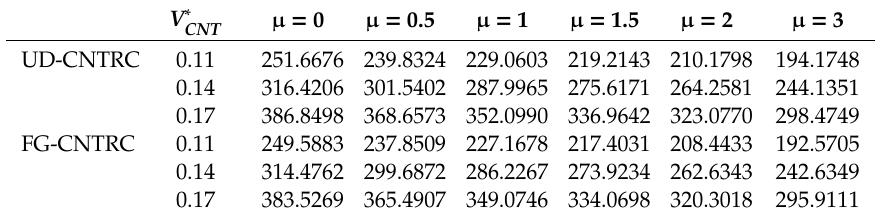
Table 5. Nondimensional critical buckling load for clamped- clamped (C-C) CNTRC curved beams with L / h = 10, α = π / 3.